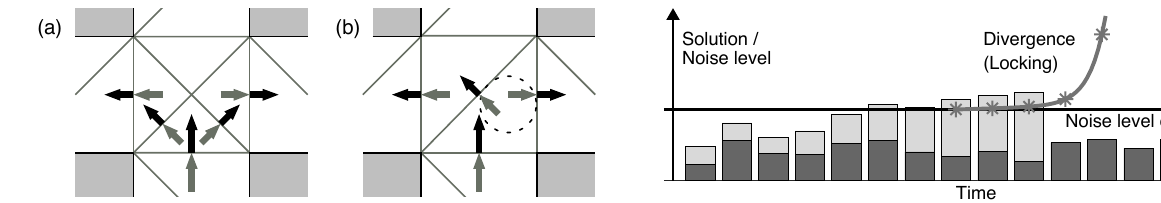
Figure 5. Noise level without (black columns) and with changes in the mesh (light columns) with the divergence (stars) leading to